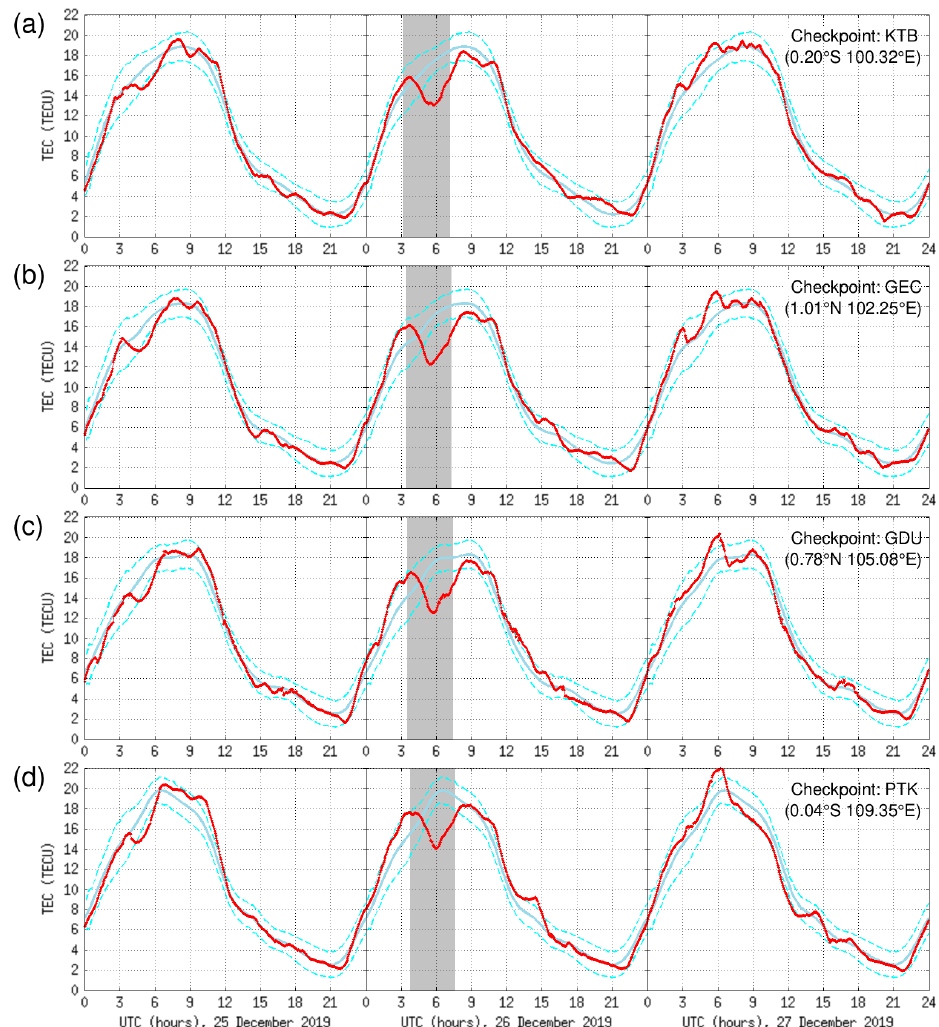
Figure 9. (a–d) Time series plots of GPS TEC at the four designated checkpoints (KTB, GEC, GDU, and PTK) on 25–27 December 2019. Smooth background TEC levels based on the 25 and 27 December 2019 data, combined with IRI model runs on 18–25 December 2019, are shown in cyan. Observation data are shown in red. The solar eclipse period is indicated with gray